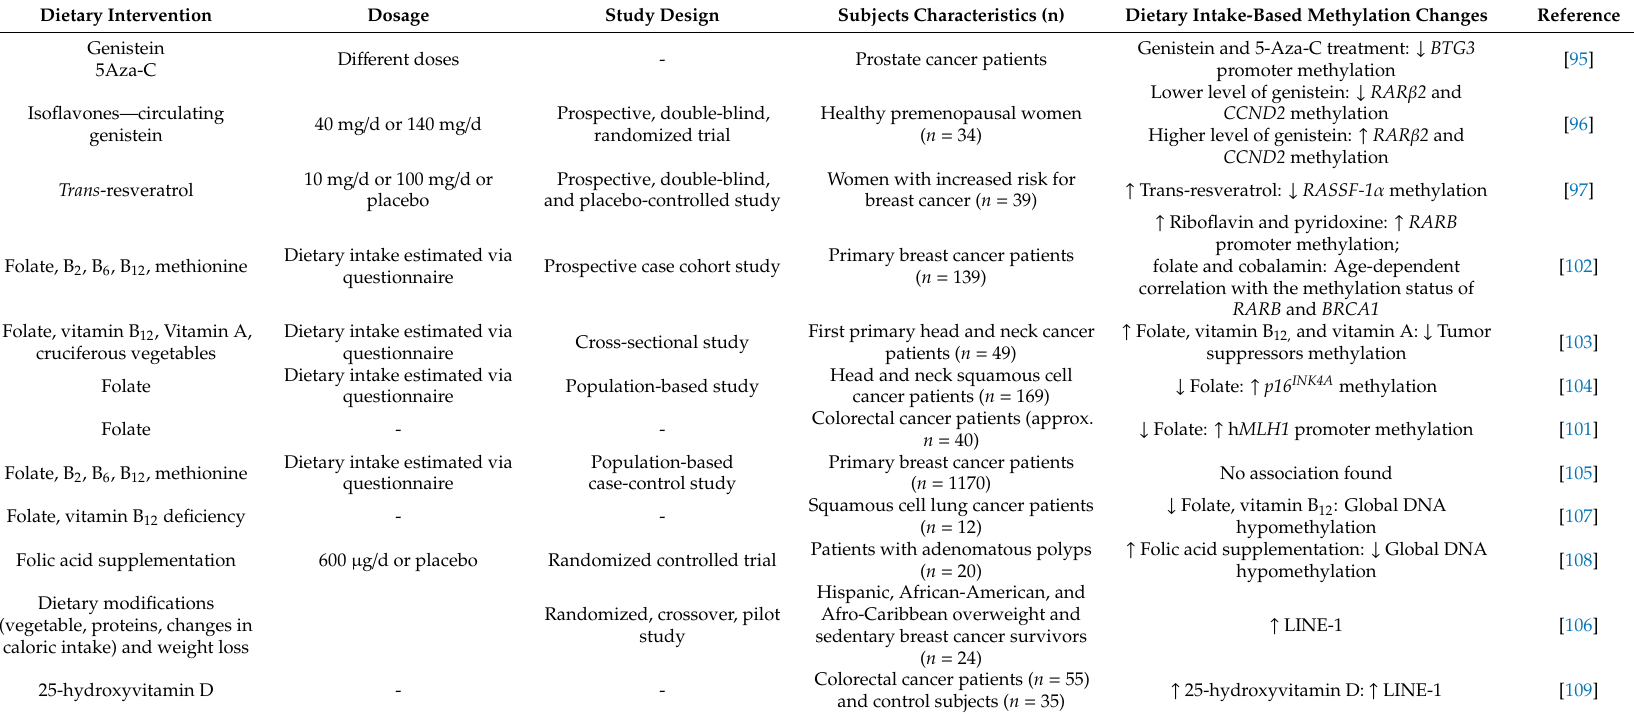
Table 3. Clinical trials describing the e ff ects of phytochemicals on DNA methylation patterns in cancer